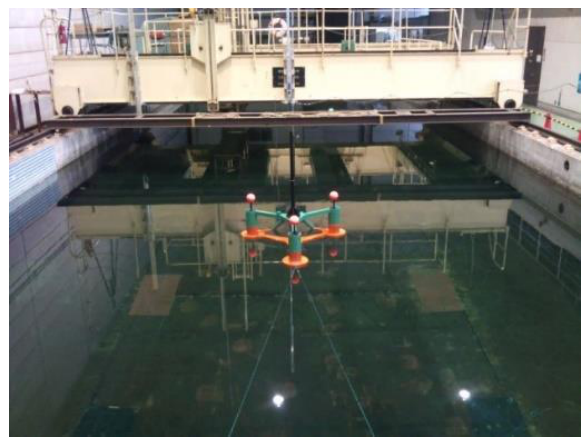
Figure 8. Overview of the water tank and platform.